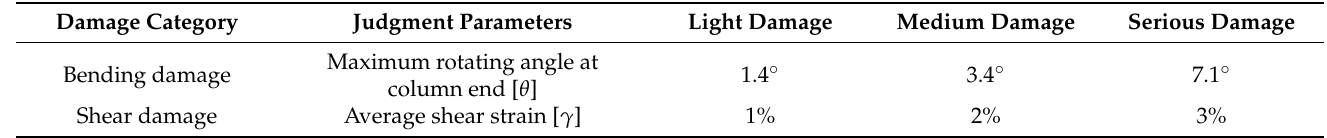
Table 6. Criteria of bending and shear